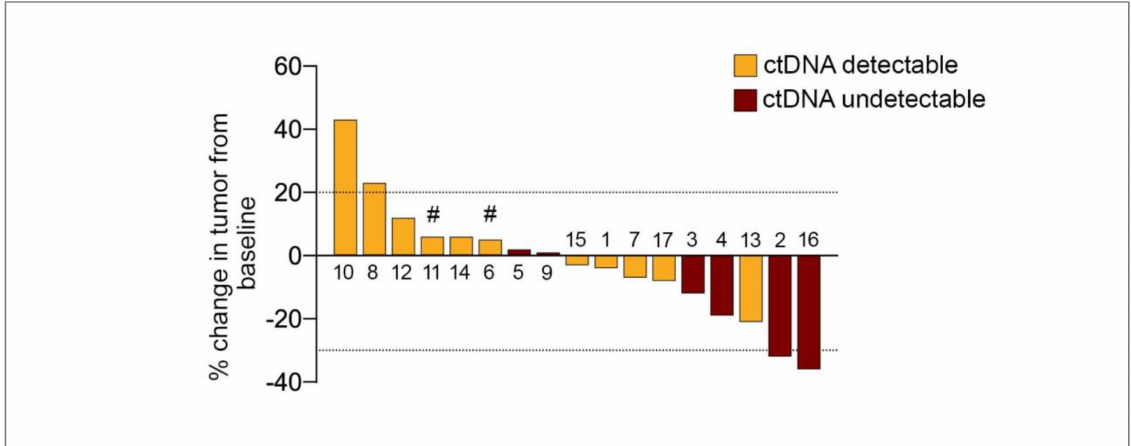
Figure 4. Treatment response in target lesions and ctDNA detectability in UM patients treated with PKCi. Percentage change in target lesions as per RECIST1.1 from 17 patients. Bars are aligned according to decreasing percentage in the sum of target lesions. Positive bars show growth in target lesions and negative bars indicate shrinkage. The dotted line corresponds to a 20% increase or 30% reduction in size of the target lesions. Patients were classified as ctDNA undetectable if at least one on-therapy plasma sample was undetectable for the driver oncogene. Patient IDs are shown above or below bars. # progression of disease with new non-target